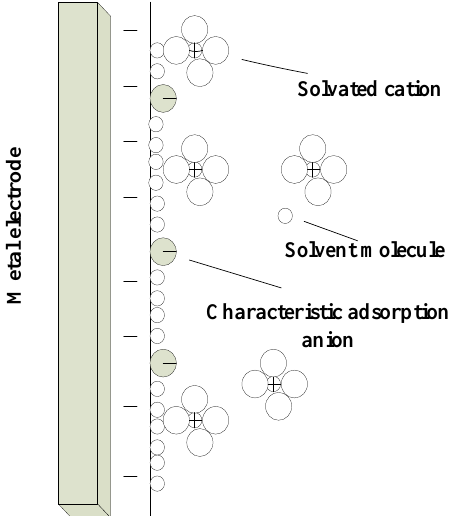
Figure 1. Schematic diagram of multi-physics coupling relationship. The electrode is not only the metal connecting the positive and negative electrodes of the power supply, but also the electrode system formed by the interface of the positive and negative electrodes and their adjacent electrolyte in the tubular electrode ECM. The details are shown in Figure 2.